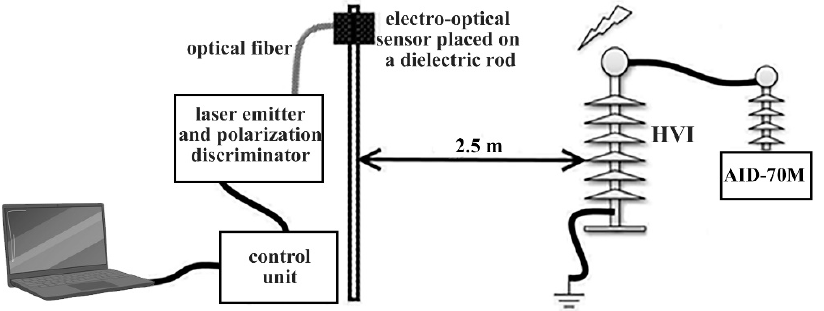
Figure 5. General scheme for measuring electric field gradients. The AID-70M is installed for testing dielectrics.